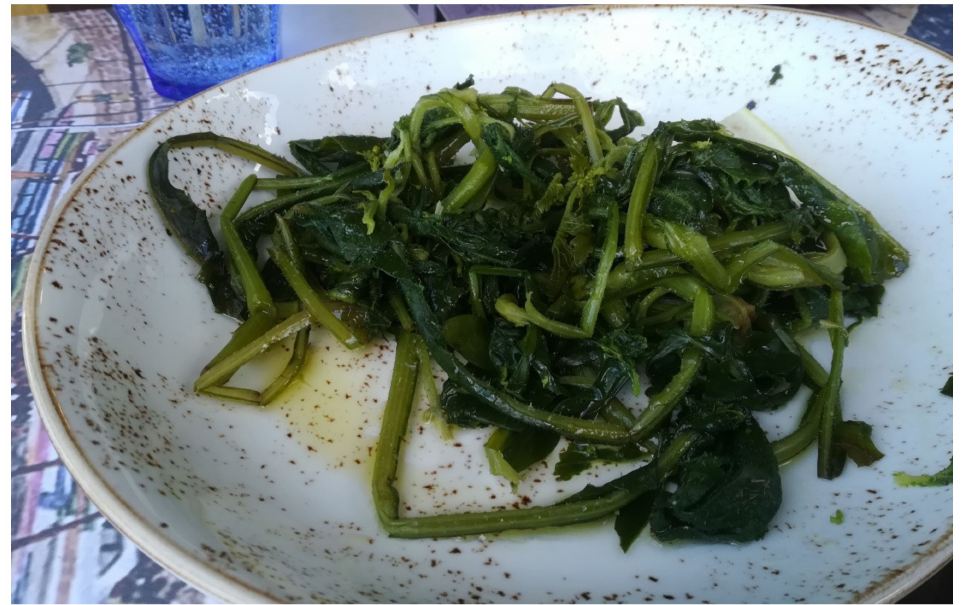
Figure 5. Boiled Cretan wild greens ( vrasta